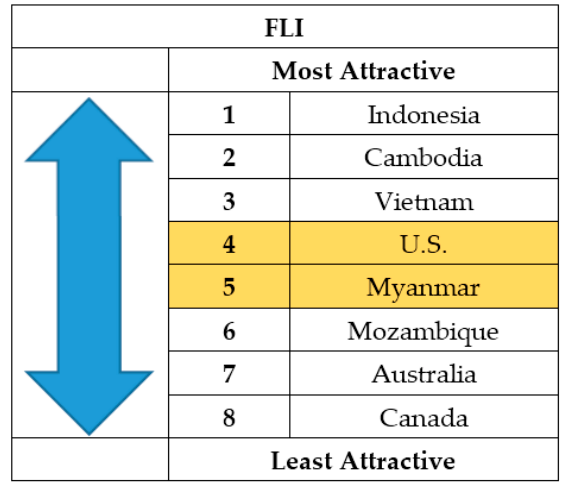
Figure 4. Attractiveness Rank of Eight Countries by FLI.